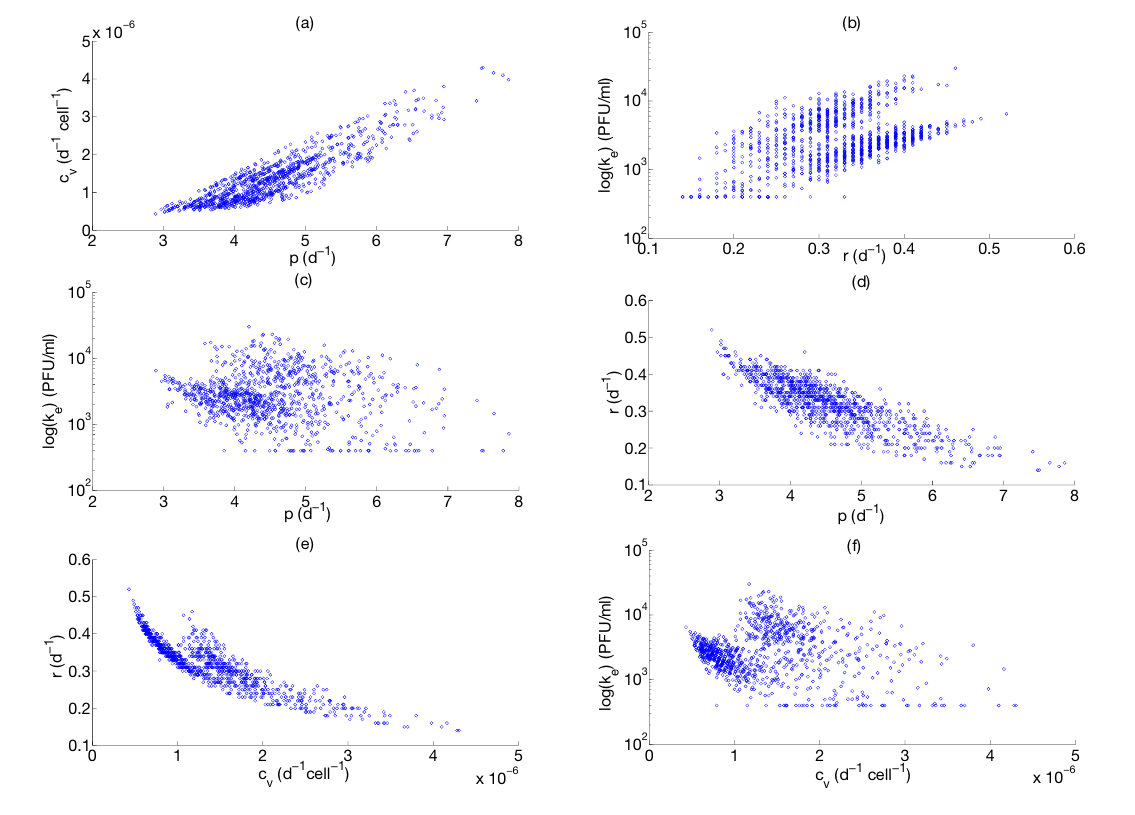
Figure 8. Scatter plot results. The scatter plots of ( a ) p - c v ; ( b ) k e - r ; ( c ) k e - p ; ( d ) r - p ; ( e ) r - c v , ( f ) k e - c v . The numerical values are obtained from the nonparametric bootstrap distributions in Figure 7. The plots show dependencies between parameters p - c v , p - r , c v - r